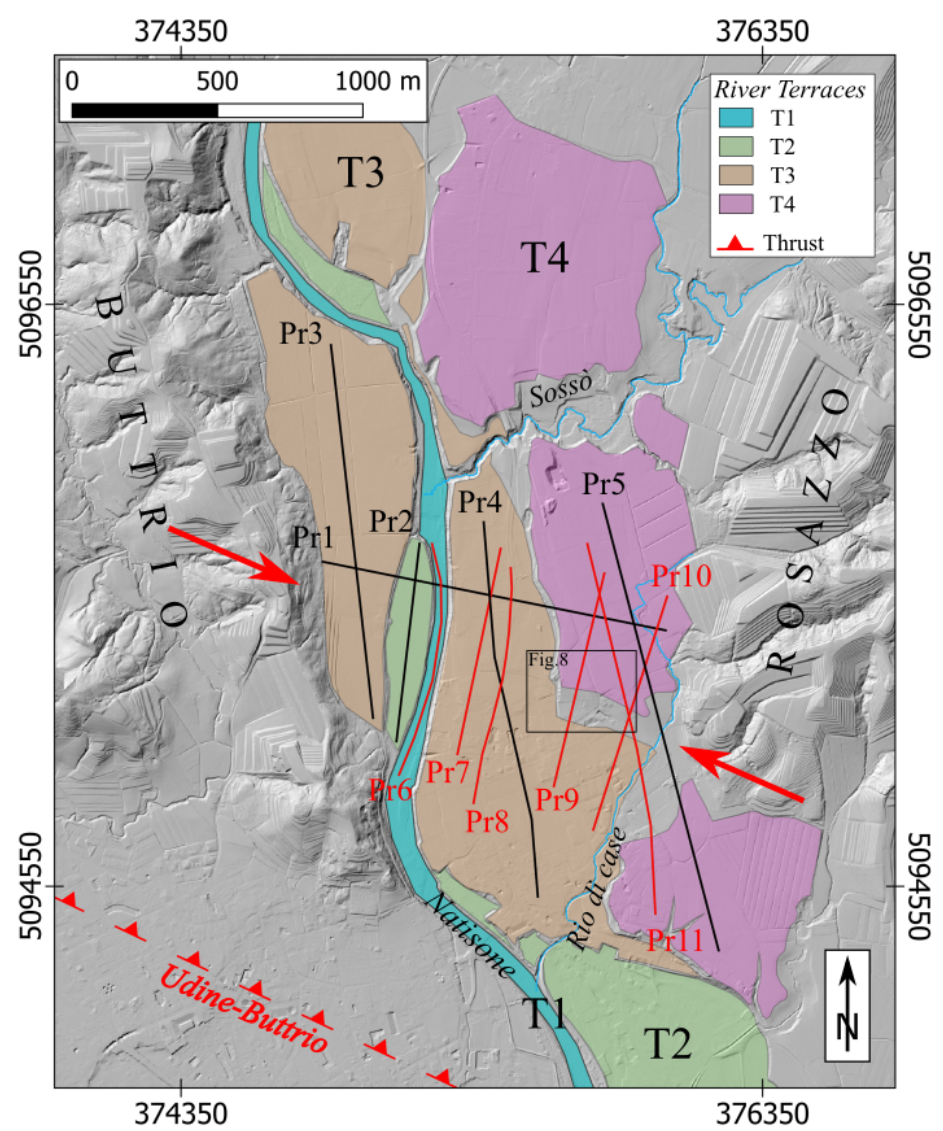
Figure 7. Hillshaded DEM of the area between the hills of Buttrio and Rosazzo. The coloured areas represent the different river terrace generations. The two red arrows highlight the scarp. The black and red segments indicate the two sets of topographic profiles shown in Figures 8 and 9, respectively. The black rectangle marks the area shown in Figure